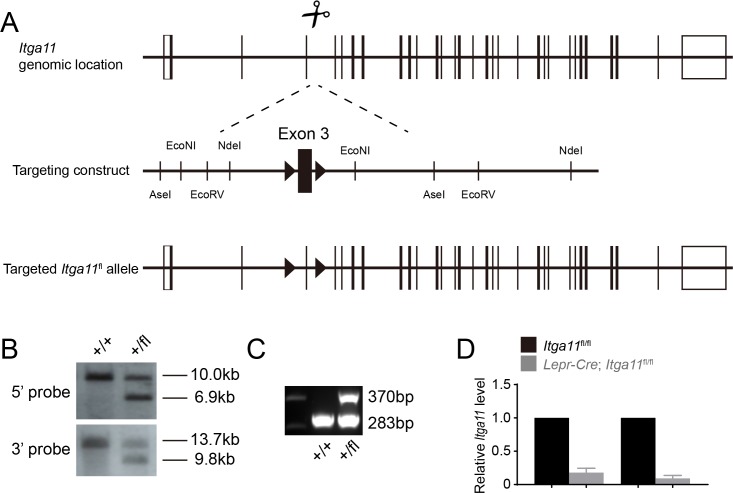
Generation of an Itga11 floxed mice.(A) DNA surrounding Itga11 exon3 was used as homologous arms for recombineering. The recombineering plasmid was modified by inserting loxP sites flanking exon3. Deletion of exon three leads to a frame shift that would be expected to give a complete loss of α11 function (Popova et al., 2007). The loxP insertion sites were chosen so as not to disrupt sequences conserved among species. Cas9 mRNA, sgRNAs, and the recombineering plasmid were microinjected into C57BL/Ka zygotes. Correctly-targeted founder mice (F0) were identified by Southern blotting (B) using an internal (3’) probe and an external (5’) probe to ensure the recombineering vector was integrated in the correct genomic location, and not in other regions of the genome. Mice were backcrossed at least three times onto a C57BL/Ka background before analysis. (C) PCR genotyping demonstrated germline transmission of the Itga11flox allele. (D) qRT-PCR analysis of Itga11 transcript levels in LepR+ cells from the bone marrow of Lepr-Cre; Itga11fl/fl and sex-matched littermate controls (n = 4 mice per genotype per time point from two independent experiments). All numerical data reflect mean ±standard deviation.10.7554/eLife.42274.014Figure 5—figure supplement 1—source data 1.Data for Figure 5—figure supplement 1.